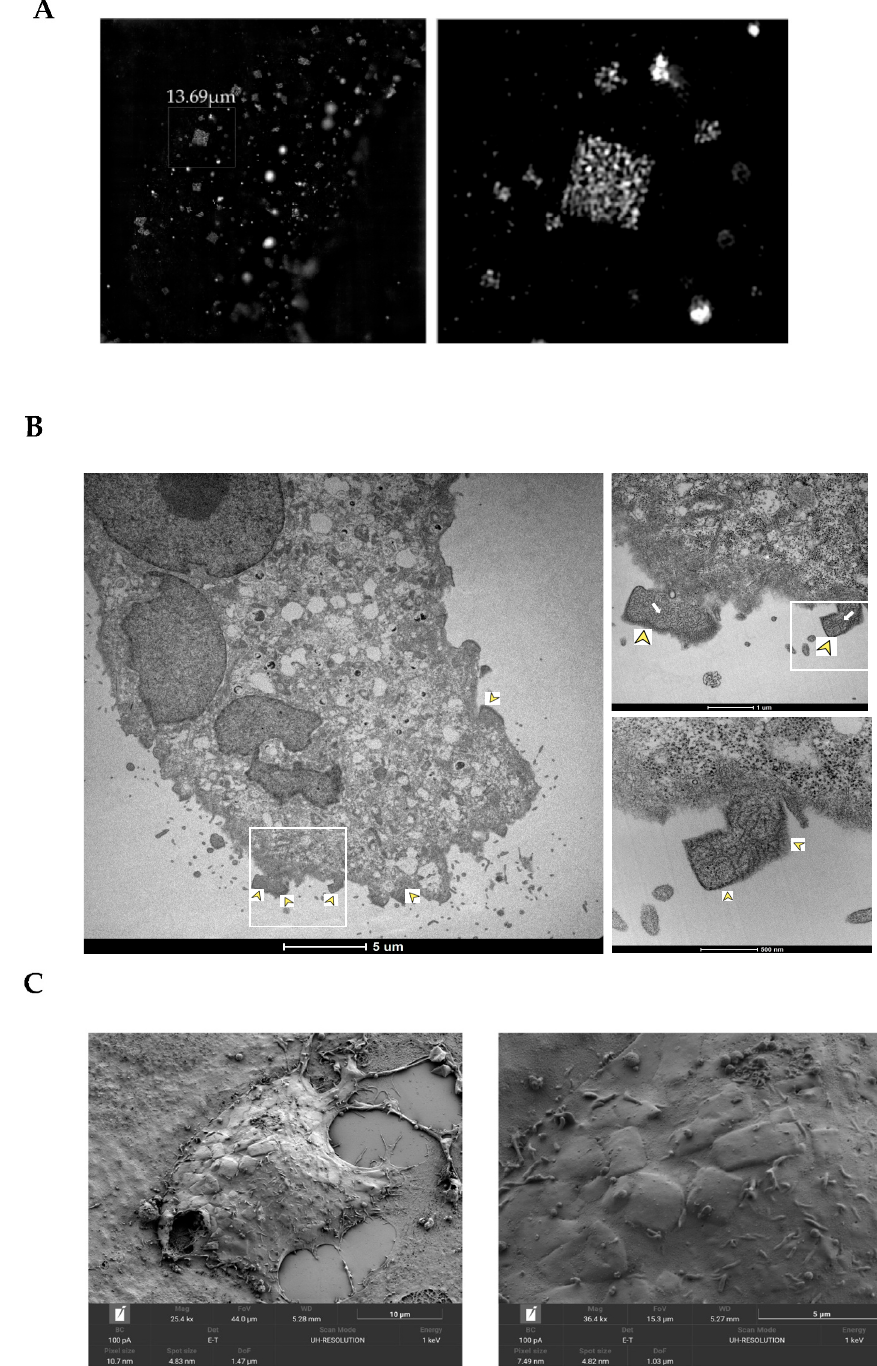
Figure 4. Detection of NiV N ordered structures with SIM, TEM, and SEM. ( A ) SIM was used to determine the regularity of single-stained entities within the NiV ordered structures, with super- resolution light microscopy. The images on the right show the magnification of the areas outlined by a rectangle in the images on the left. ( B ) TEM-overview of a NiV-infected Vero E6 cell, with magnified areas showing the ordered structures (yellow arrow heads) and RNCs (white thick arrows). ( C ) Scanning electron microscopy (SEM) of NiV-infected Vero E6 cells. NiV organized structures are displayed on the surface of the cell. In the right image, a magnification of the area in the left image showing the NiV rhombohedron-like structures.